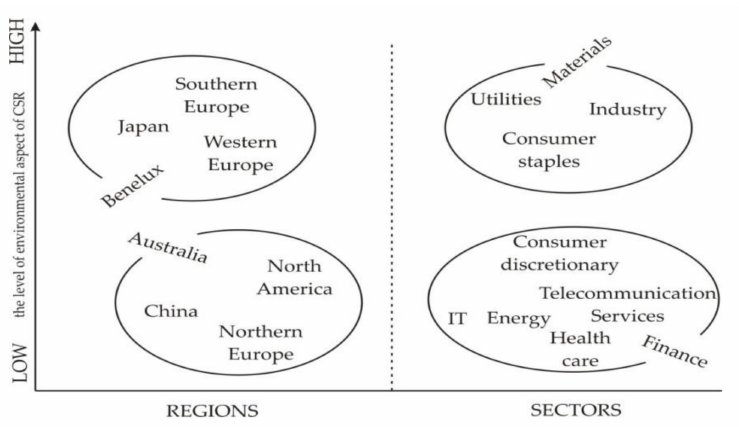
Figure 6. High- and low-scoring groups in terms of the environmental aspect of CSR. The division into low- and high-scoring groups was made on the basis of the research results and verification of the statistical significance of the differences. Sectors/regions belonging to the low-scoring group scored significantly lower than all representatives of the high-scoring group, and at the same time did not differ significantly in this respect from each other within the group. The high-scoring group was determined